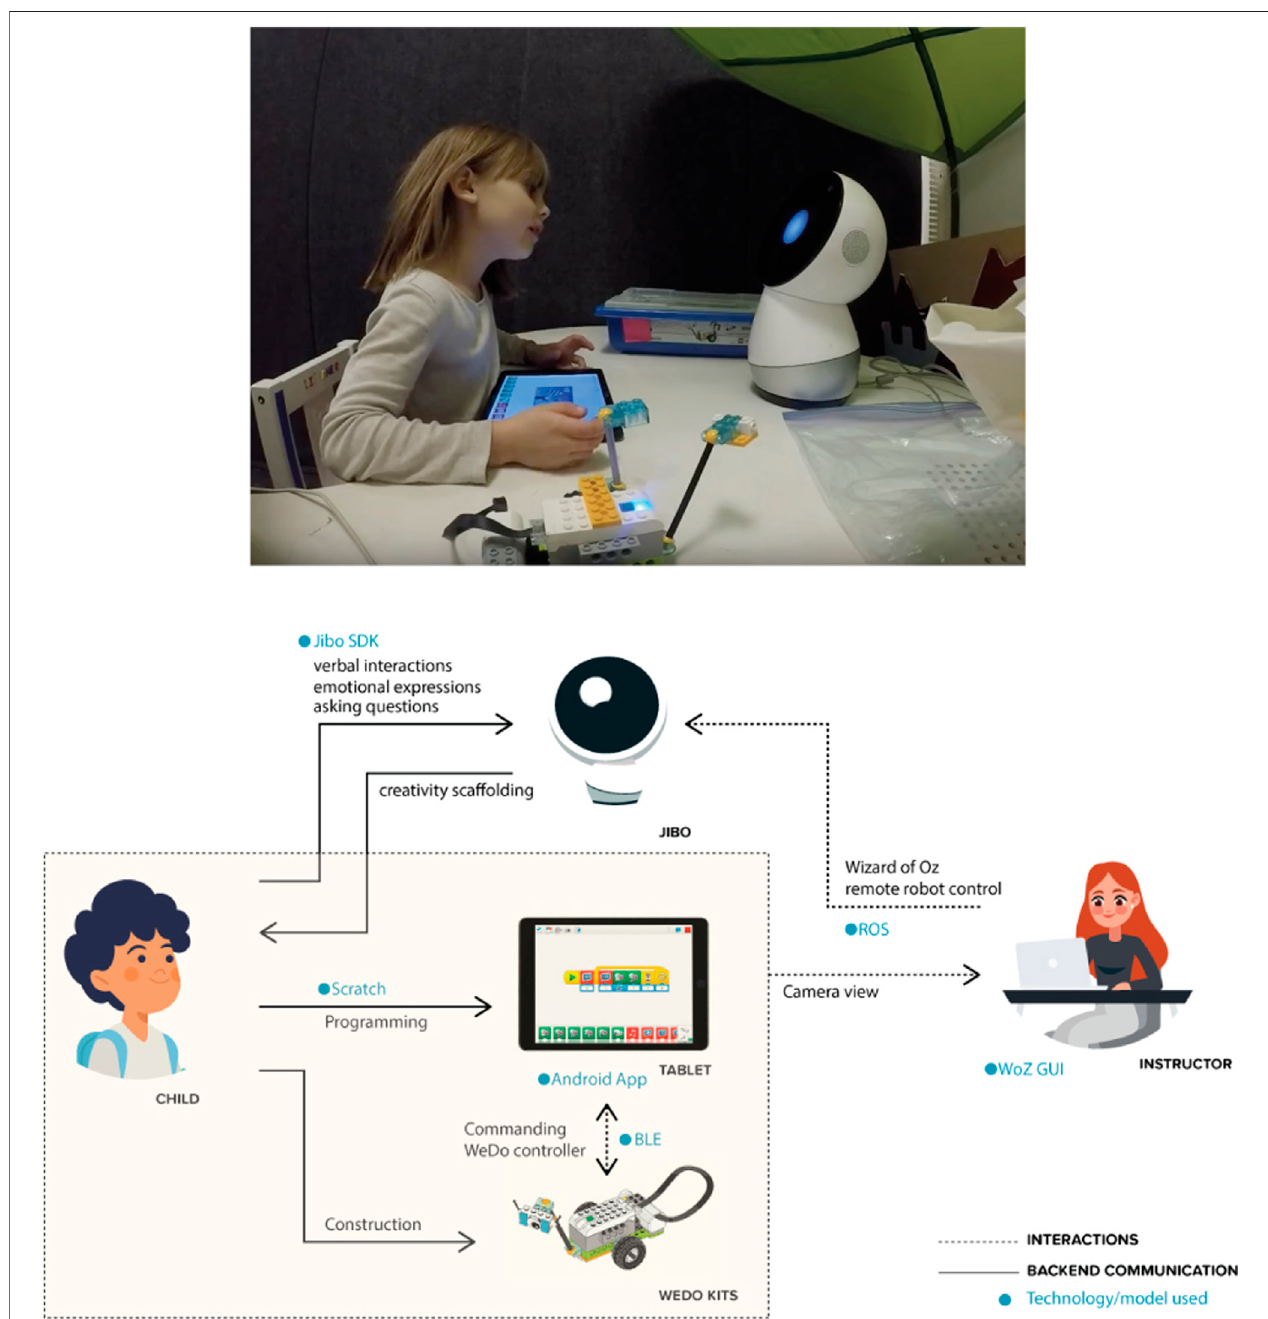
FIGURE 3 | (top) (A) Child constructing models with Jibo. (bottom) (B) Model of interaction for the WeDo construction game where the robot provides creativity scaffolding.